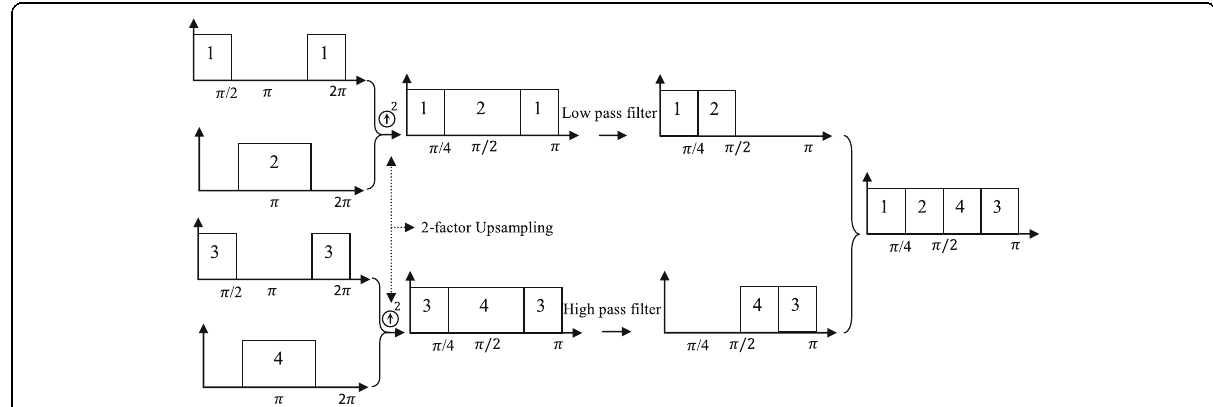
Fig. 8 The frequency split of spectrum in 4-band synthesis tree-structured filter bank of ideal